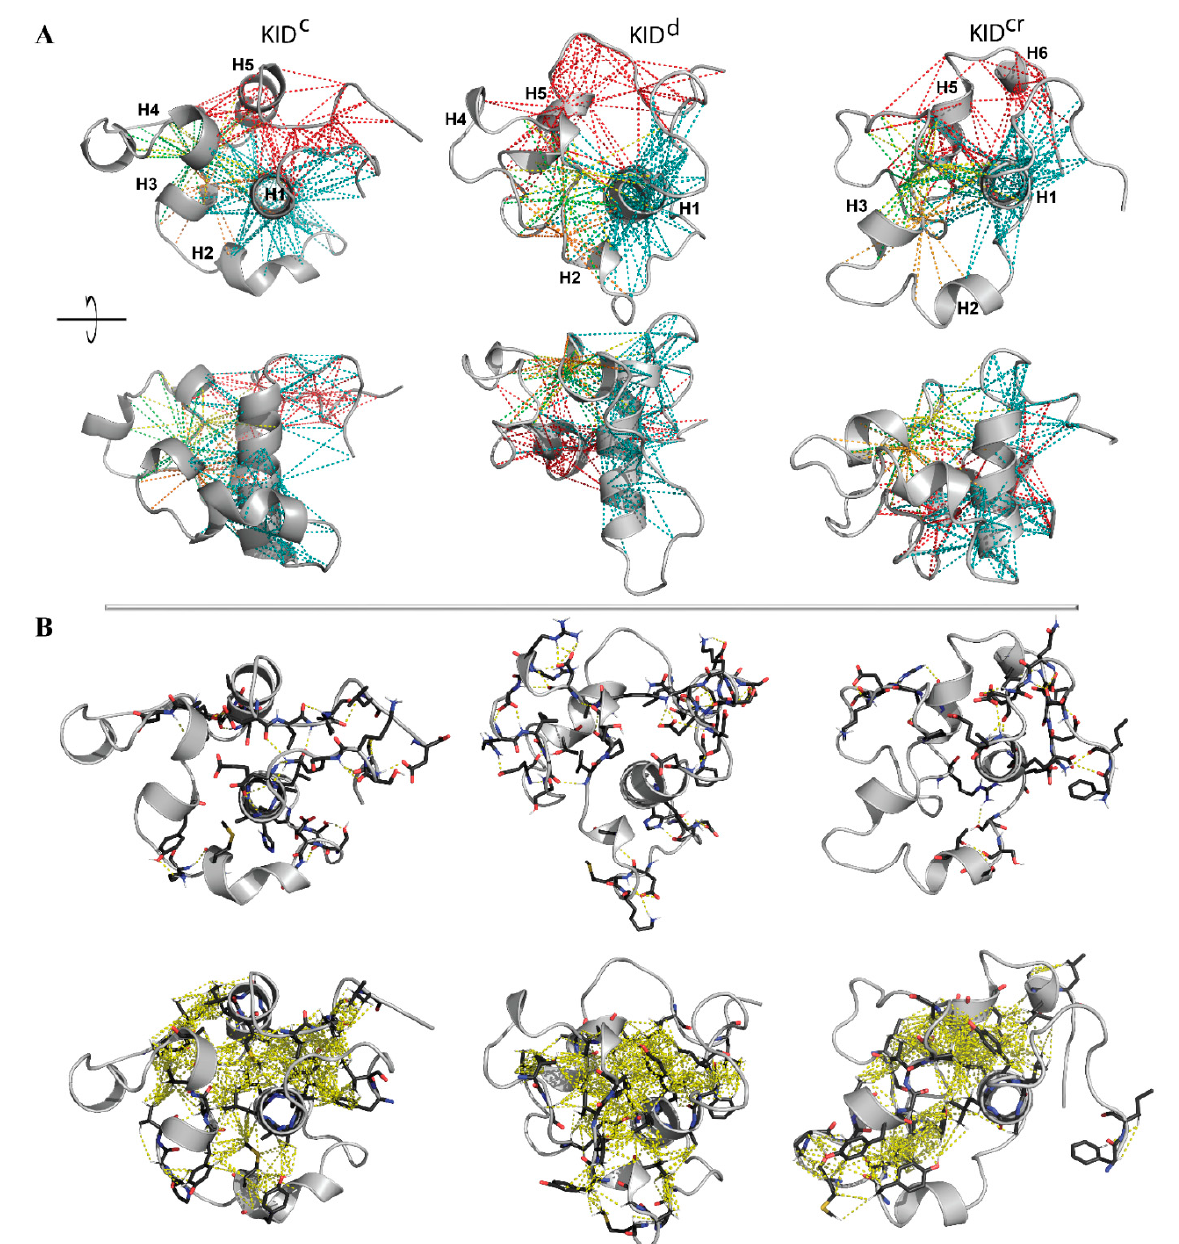
Figure 4. Non-covalent interactions maintaining the inherent (intrinsic) 3D structure of KID. ( A ) The intramolecular contacts, H-bonds and hydrophobic interactions (dashed lines), formed by residues E699–709 (H1) (in teal), P754-L764 (H5) (in red) and V731/V732/P733 (orange/green/yellow) with all the residues of KID at least in one trajectory, are superimposed on a randomly chosen KID conformation shown in two orthogonal projections. Protein is shown in grey ribbons, helices H1–H6 are labelled for KID C . ( B ) H-bonds (D-H · · · A ≤ 3.6 Å, where D (D = O/N/S) is a donor atom and A (A = O/N/S) is an acceptor atom) (top) and van der Waals contacts (C-H · · · A = O/N/S ≤ 4 Å) between all side chain atoms (bottom) are shown on a randomly chosen conformation. ( A , B ) The interactions stabilising the regular structures (helices) are not considered.